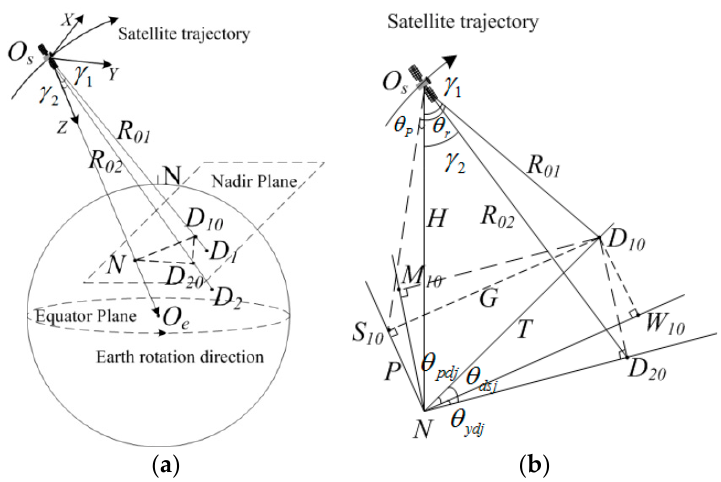
< D < D 10 ND 20 and 10 O s D 20 change periodically if the satellite is in the state of no-attitude steering. H is the satellite height. θ yj and θ pj , as simulated in Figure 1, respectively, represent the yaw and pitch angle offset zero Doppler plane in the state of no attitude steering. θ dj is the original GSA, which consists of θ ydj from θ yj and θ pdj from θ pj . P represents the range between N and S 10 , T represents the range between N and D 10 , and G represents the range between D 10 and S 10 . To simplify the analysis process, this paper assumes that the beam center direction is consistent with the Z -axis of SLCS, and they both point to the earth core in the state of no attitude steering.